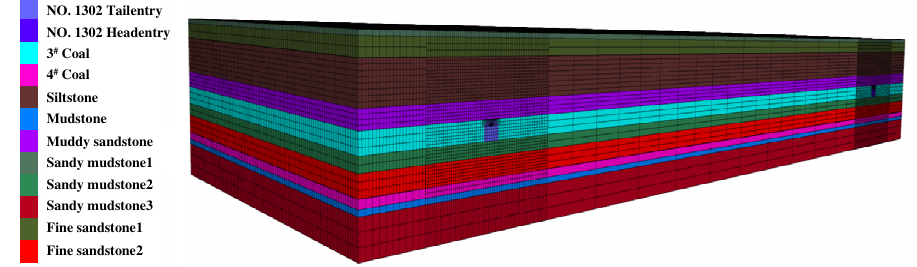
Figure 14. Numerical calculation model.